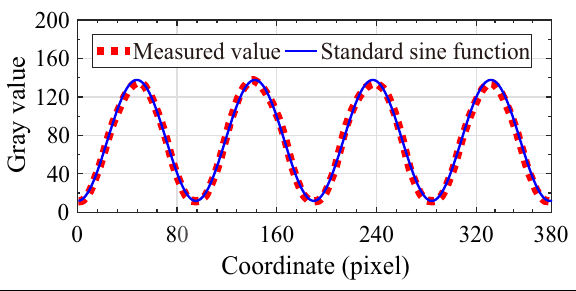
Figure 5. The generated sinusoidal fringe pattern and the comparison of intensity distribution between the generated sinusoidal signal and the standard sine